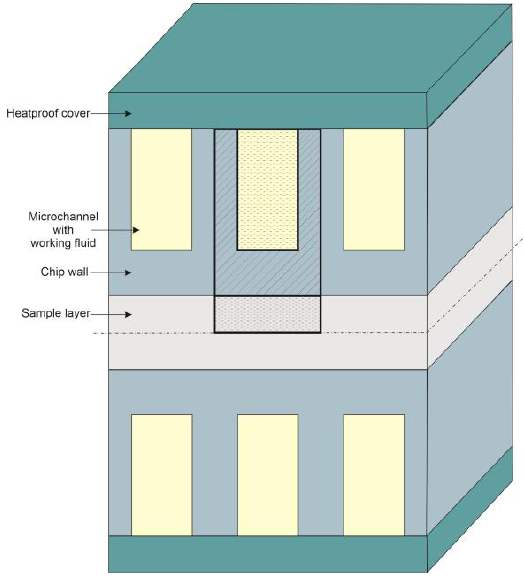
Figure 1. Schematic model of microfluidic system.